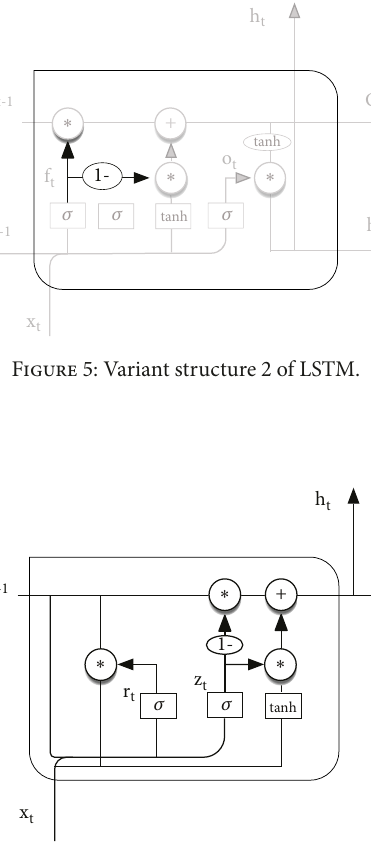
Figure 6: Variant structure 3 of LSTM.